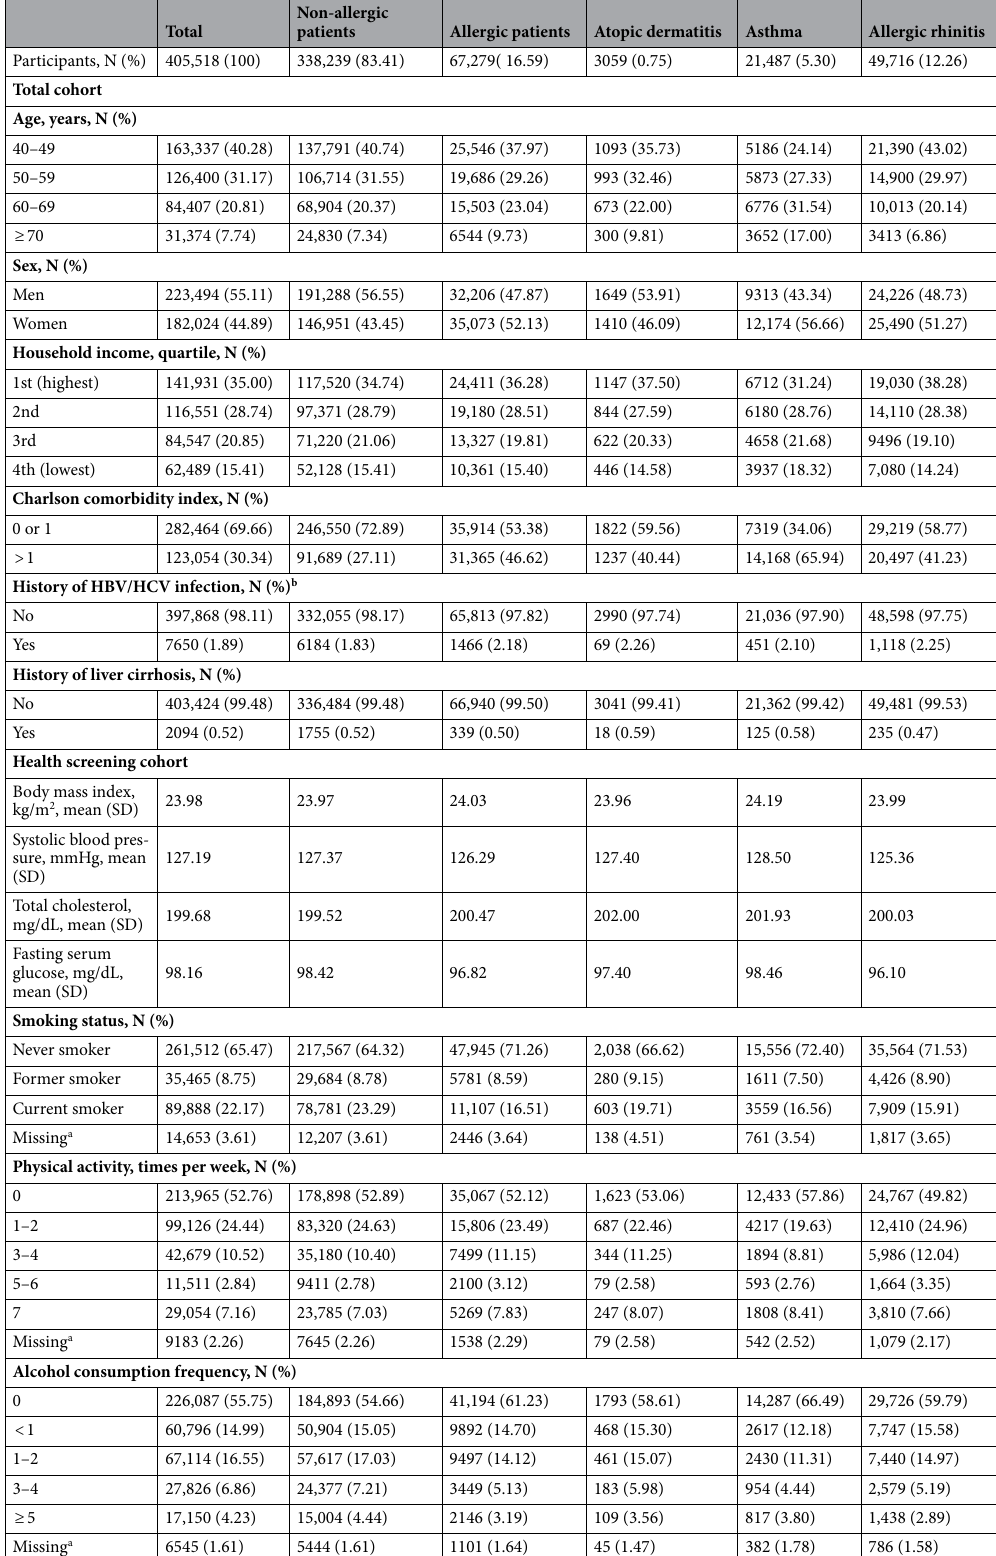
Table 1. Descriptive characteristics of the study population. a Participants with lifestyle related variables missing are marked. b Having a history of hepatitis B/C virus infection was defined as having a disease code of either hepatitis B or hepatitis C described in the medical record of the